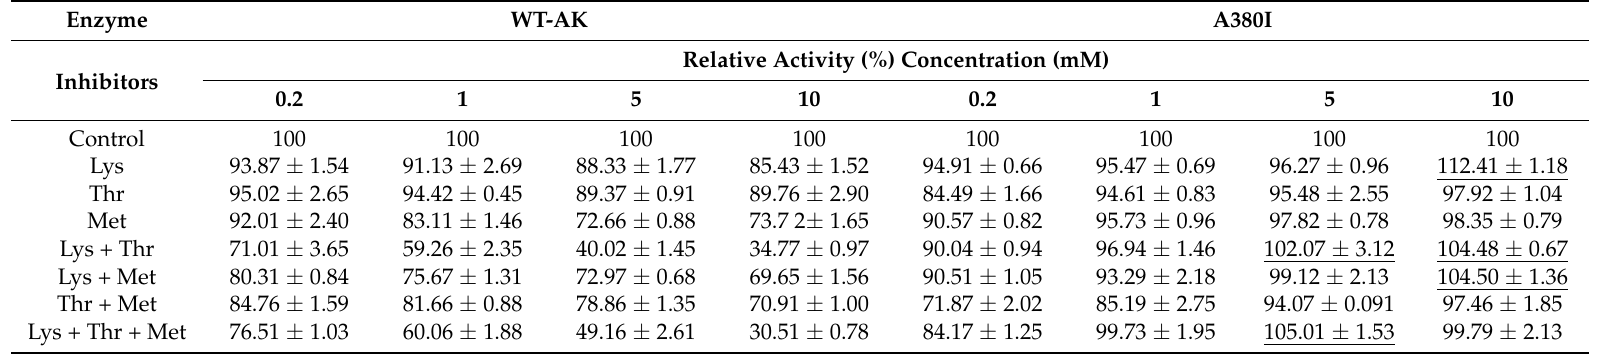
Table 1. Substrate inhibitor of WT-AK and